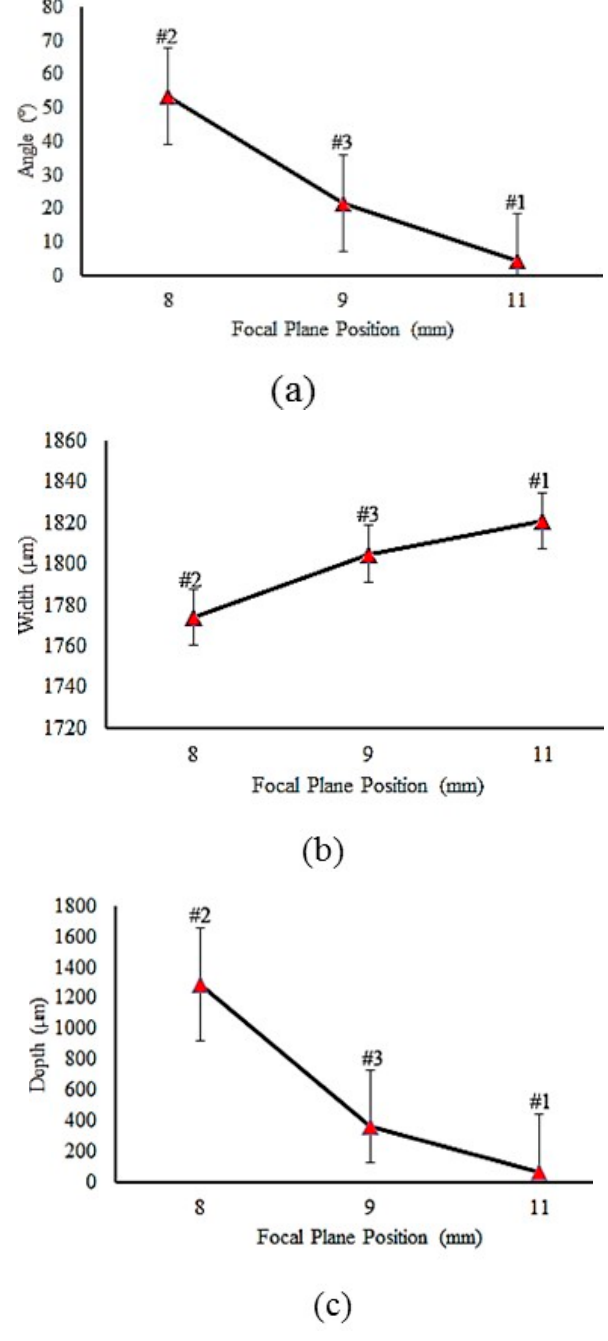
Figure 6. Influence of the focal plane position on LH (Laser Hardening Process) profile geometry. ( a ) Focal plane position on angle (samples #1, #2 and #3) ( b ) Focal plane position on width (samples #1, #2 and #3) ( c ) Focal plane position on depth (samples #1, #2 and #3).